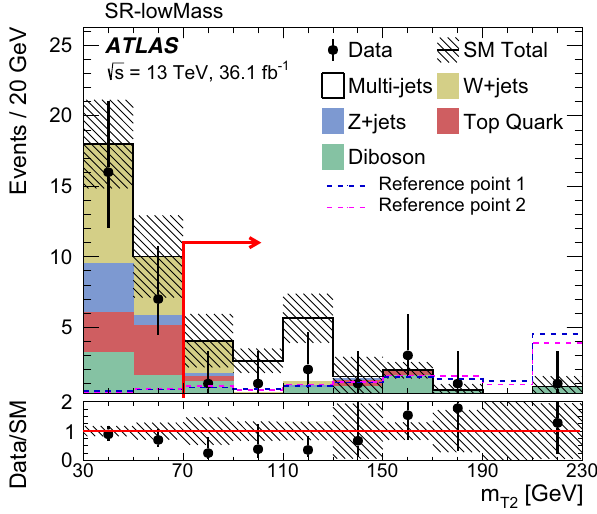
Fig. 6 The m T2 distribution before the m T2 requirement is applied for SR-lowMass (left) and SR-highMass (right) regions, where the arrow indicates the position of the cut in the signal region. The stacked his- togramsshowtheexpectedSMbackgrounds.Themulti-jetcontribution is estimated from data using the ABCD method. The contributions of multi-jet and W + jets events are scaled with the corresponding nor-